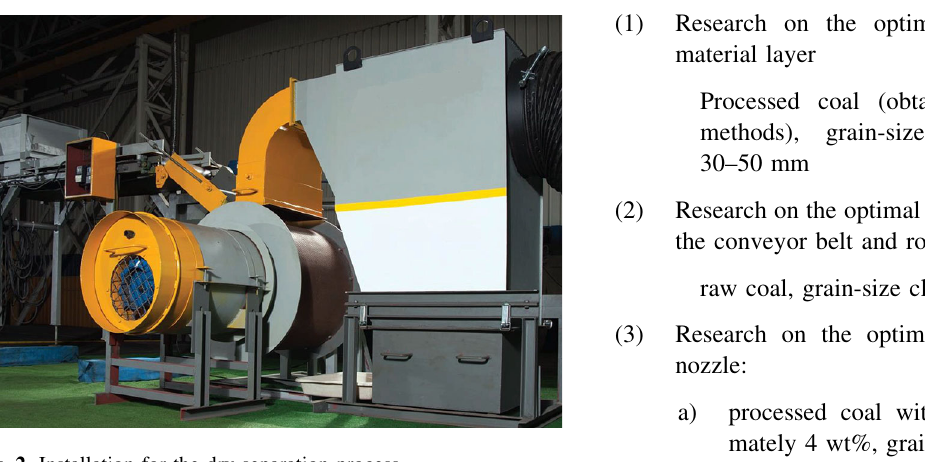
Fig. 2 Installation for the dry separation